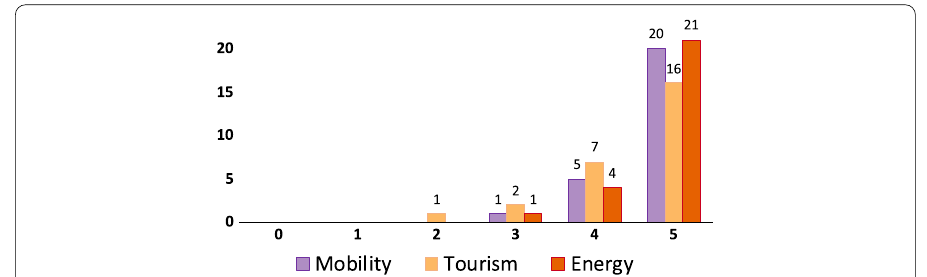
Fig. 5 Participants’ consideration about the relation between mobility/tourism/energy and